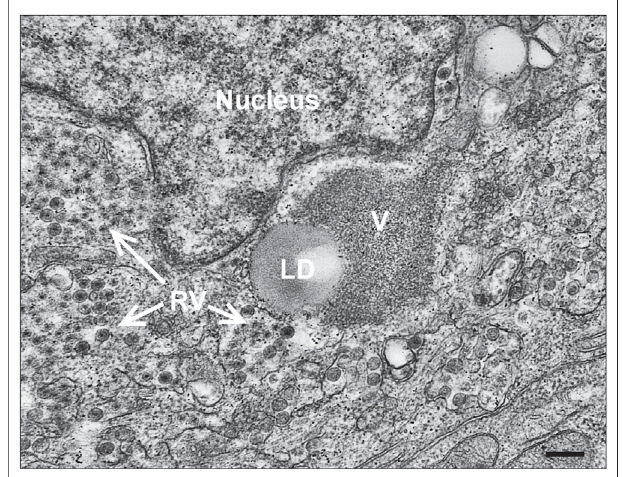
FIGURE 5 | Viroplasm/lipid droplets form in RV-infected HIEs. Electron micrograph of an infected cell within an enteroid. RV particles adjacent to a lipid droplet (LD) and viroplasm (V) are shown (bar = 250 nm). [From Saxena et al., 2016 (Saxena et al., 2016)].